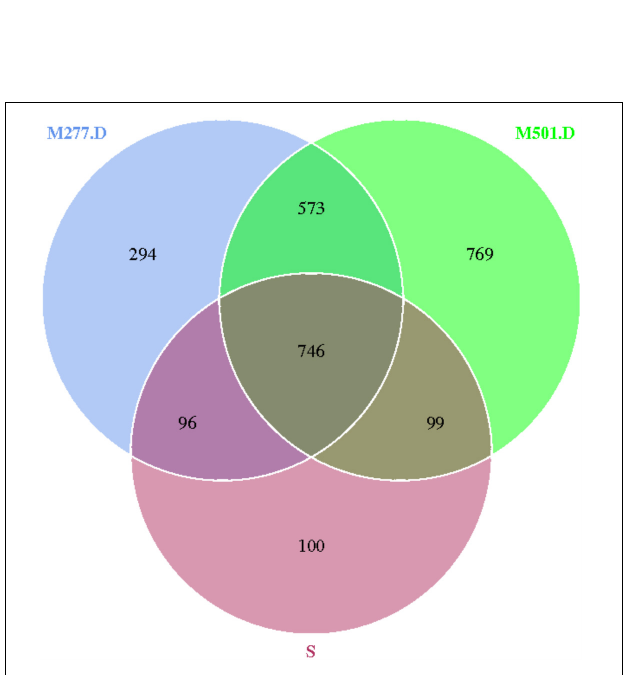
FIGURE 5 | Wayne plot of OTU number in soil samples from M277.